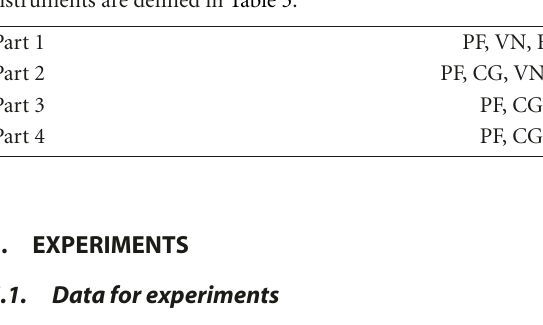
Table 4: Instrument candidates for each part. The abbreviations of instruments are defined in Table 3.